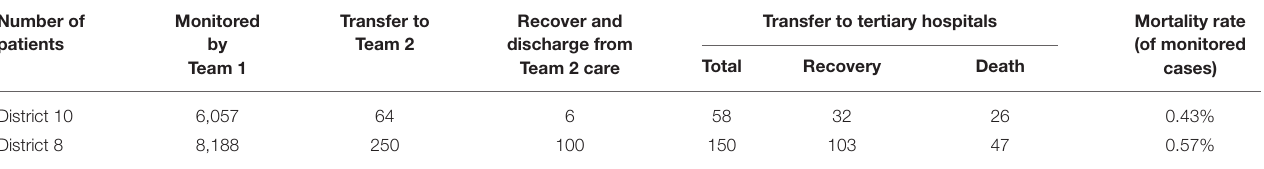
TABLE 1 | Summary of treated patient numbers and